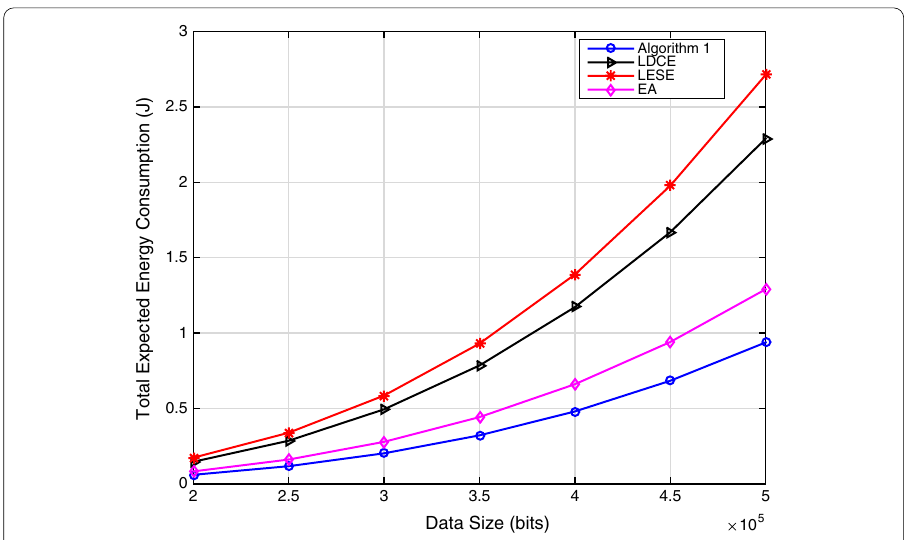
Fig. 3 Total expected energy consumption versus data